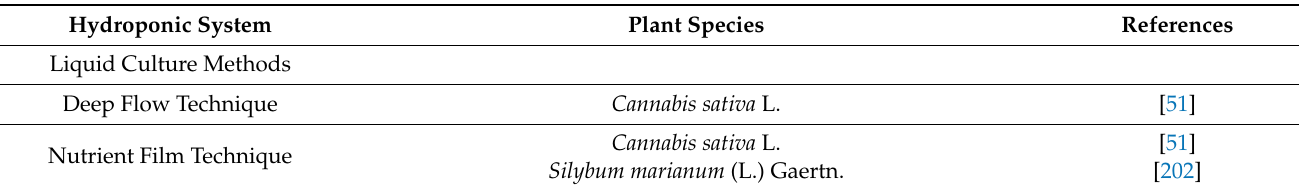
Table 4. Examples of publications discussing hydroponic cultivation of medicinal plants whose fruits or seeds are